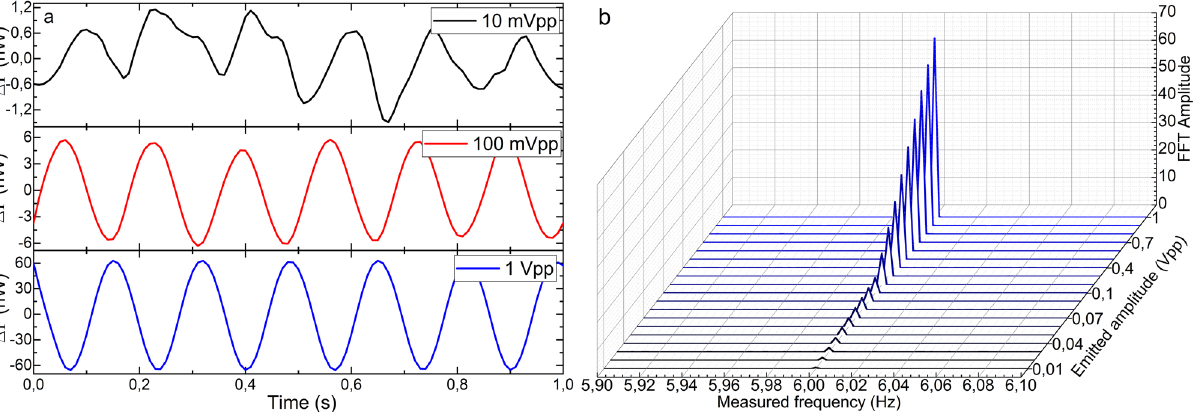
Figure 9. Results of the power variation measurements in the manufactured optical device. ( a ) Time response of three representative cases, and ( b ) FFT amplitudes for sinusoidal signals of 6 Hz and amplitudes from 1 Vpp down to 10 mVpp.